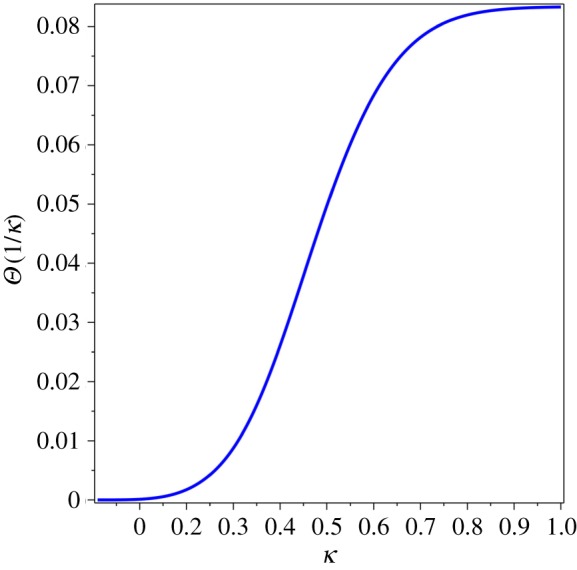
Θ(1/κ) for n = 10 000.